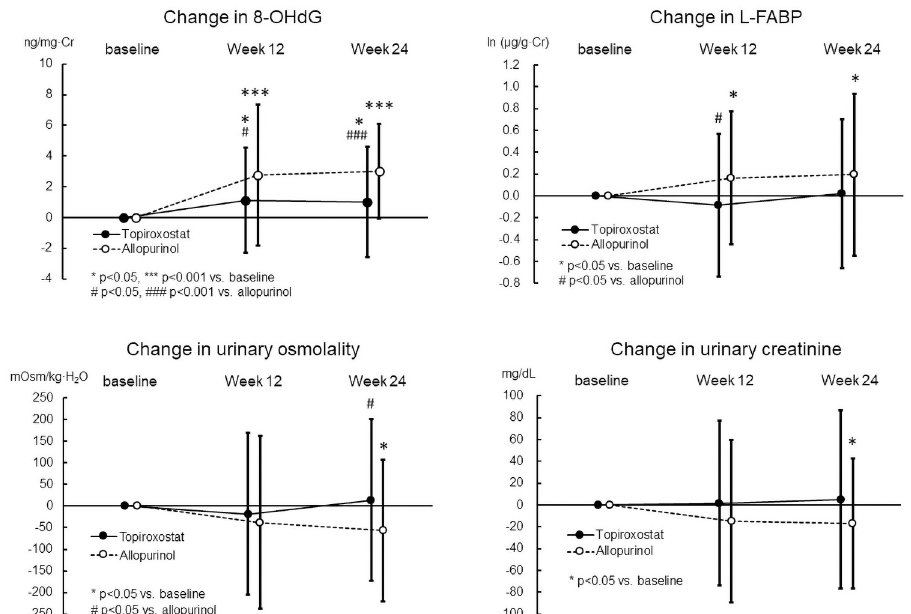
Fig 2. Serial changes of urinary 8-OHdG, L-FABP, osmolality and creatinine levels at weeks 12 and 24. Values are mean ± standard deviation. For the changes in the values 24 weeks from baseline were assessed using the paired Student’s t-test in each group. For the difference between both groups analyzed using the unpaired t-test.